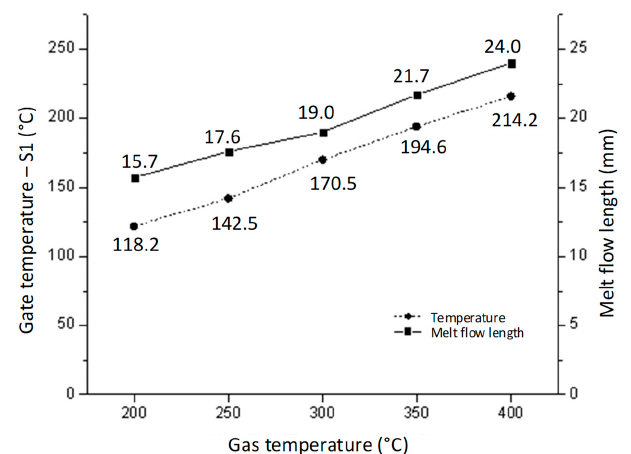
Figure 18. The melt flow length and gate temperature under different gas temperatures for the In- GMTC.